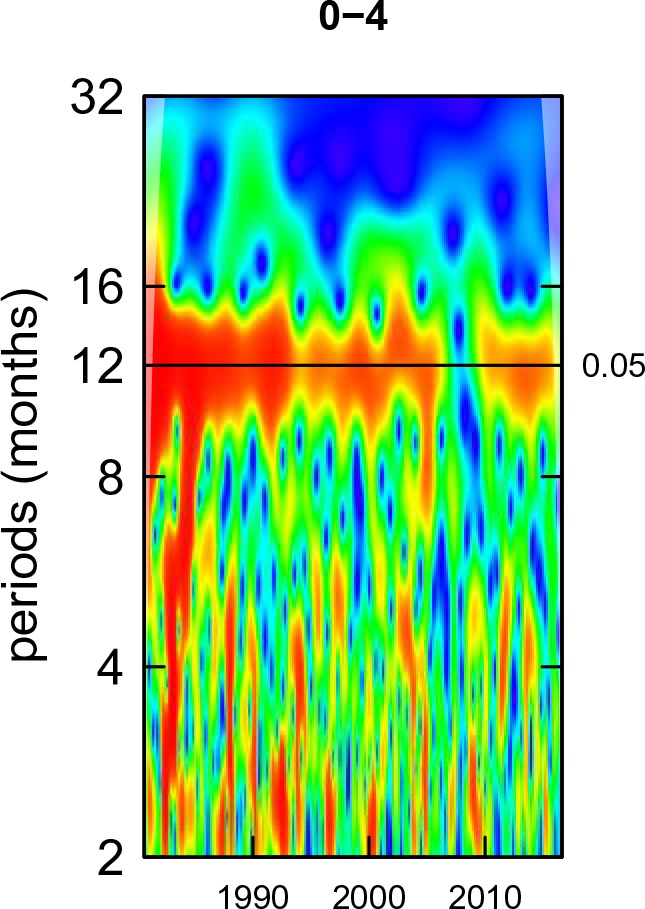
Wavelet power spectra for national time series of perinatal condition death rates for 1980–2016, by age group for females.Wavelet power values increase from blue to red. The shaded regions at the left and right edge of each box indicate the cone of influence, where spectral analysis is less robust. P-values for the presence of 12 month seasonality are to the right of each figure at the 12 month line.